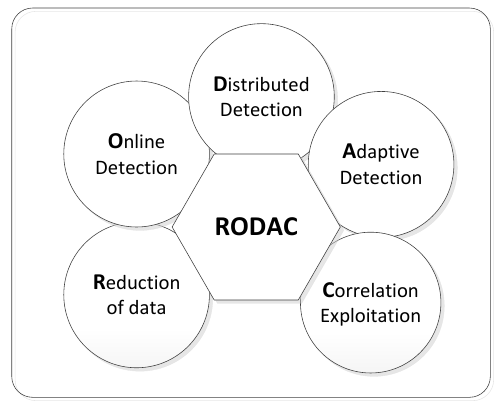
Figure 1. Requirements of Anomaly Detection in WSNs